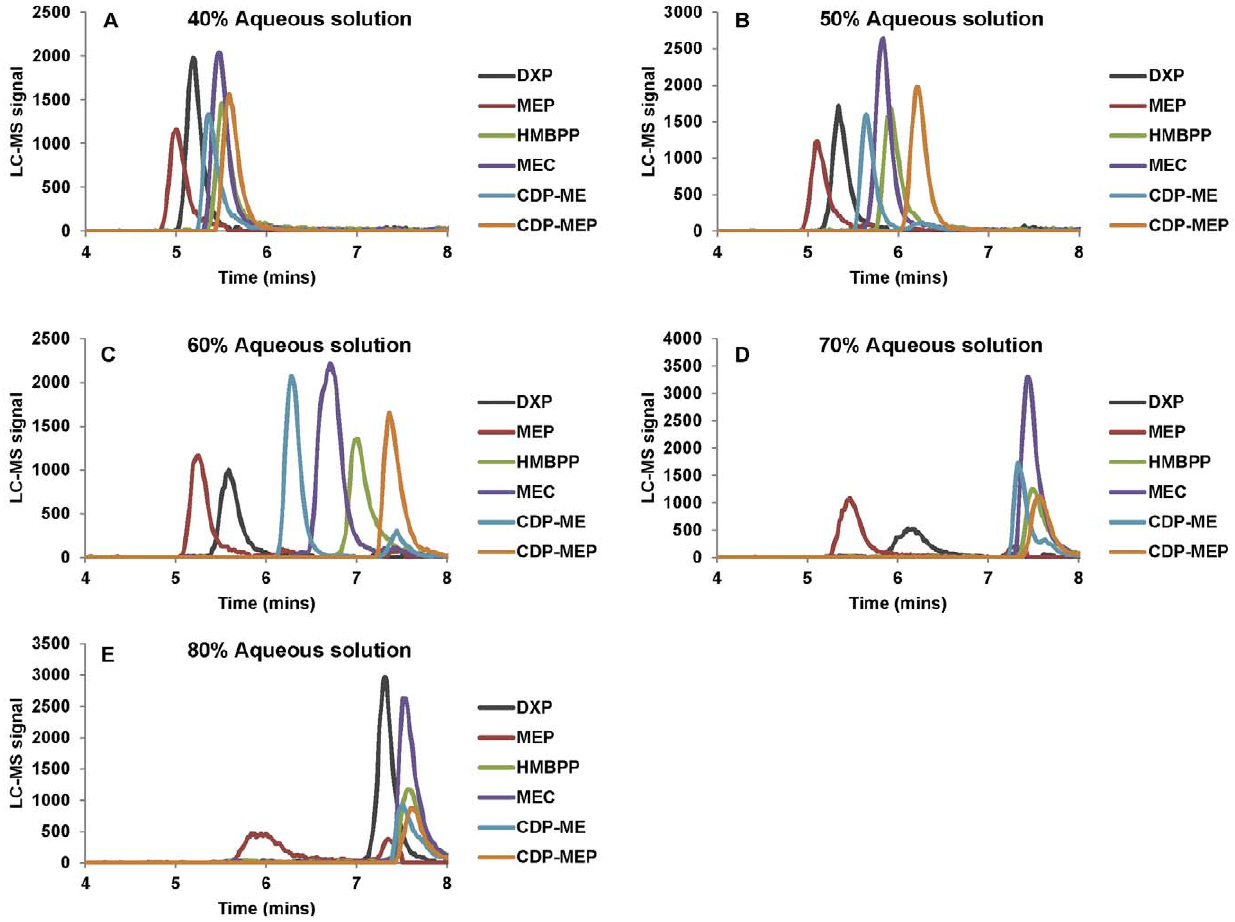
Figure 2. Effects of UPLC gradient on chromatography separation of the DXP pathway intermediates. Different concentrations (0.8, 0.4, 2.6, 2.6, 0.5 and 2 m M respectively) of DXP, MEP, CDP-ME, CDP-MEP, MEC, and HMBPP were prepared in 1 mL acidic extraction solution and purified as described in METHODS AND MATERIALS. Quantification m/z ratio for each compound was extracted from total ion chromatography as Table 1 and traces were overlaid. (A) UPLC gradient described was employed as Table 2 except 40% aqueous solution was used in step 3 and 4; (B) UPLC gradient described was employed as Table 2 except 50% aqueous solution was used in step 3 and 4; (C) UPLC gradient described was employed as Table 2; (D) UPLC gradient described was employed as Table 2 except 70% aqueous solution was used in step 3 and 4; (E) UPLC gradient described was employed as Table 2 except 80% aqueous solution was used in step 3 and 4.